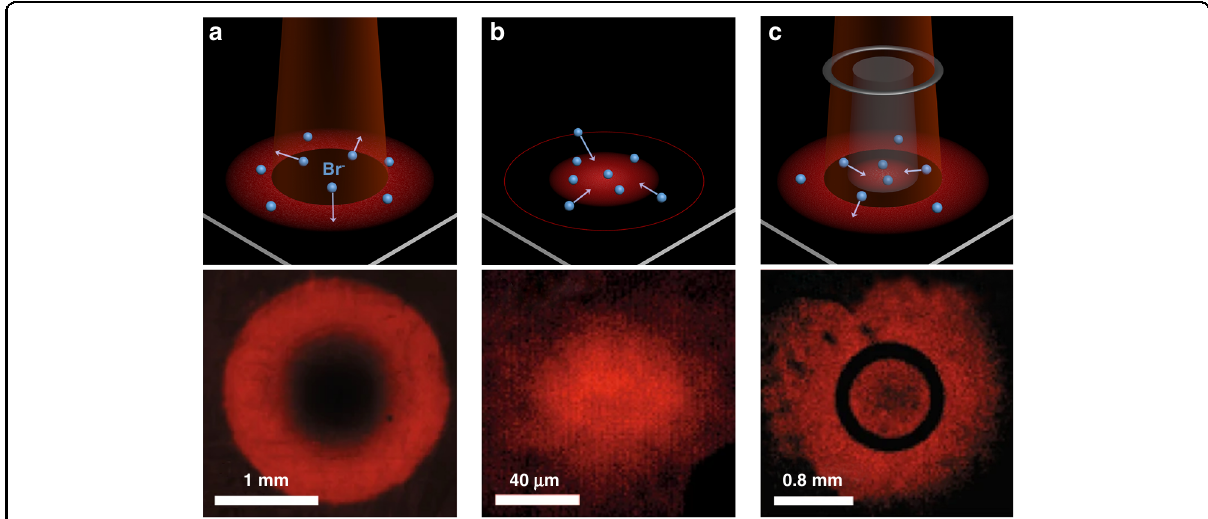
Fig. 1 Schematic illustration and experimental photoluminescence mapping of Br ion migration. a Under illumination with a beam size of ~1 mm, b when the illumination is removed, and c under illumination with an annular laser beam. All the experimental results were detected at the wavelength of 670